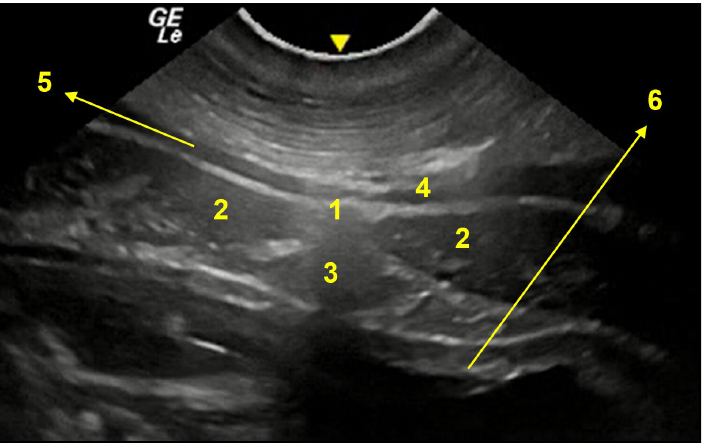
Figure 12. Transversal image of the pre-umbilical region (A). 1. linea alba; 2. rectus abdominis muscle; 3. falciform fat; 4. cutaneous muscle; 5. profound fascia together with aponeurosis of external abdominal oblique muscle; 6. transversus abdominis muscle together with parietal peritoneum; 7. uterine horn wall. Below, fetuses within 110 days of gestation. Animals 2023 , 13 , x